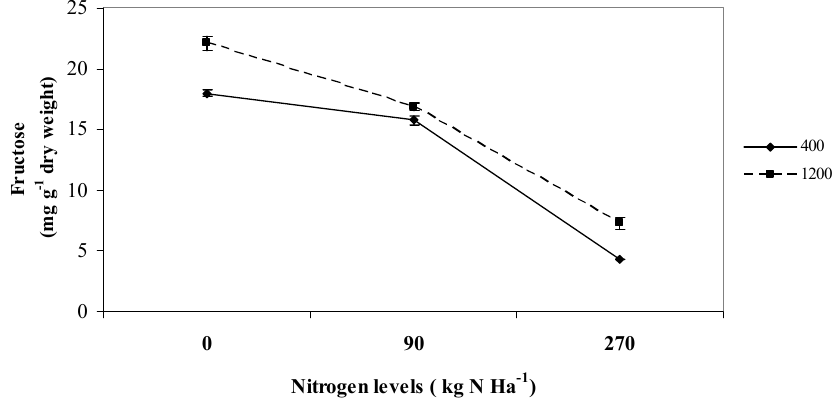
Figure 1. Interaction effects between CO content of L. pumila . N = 12. Bars represent standard error of differences between means